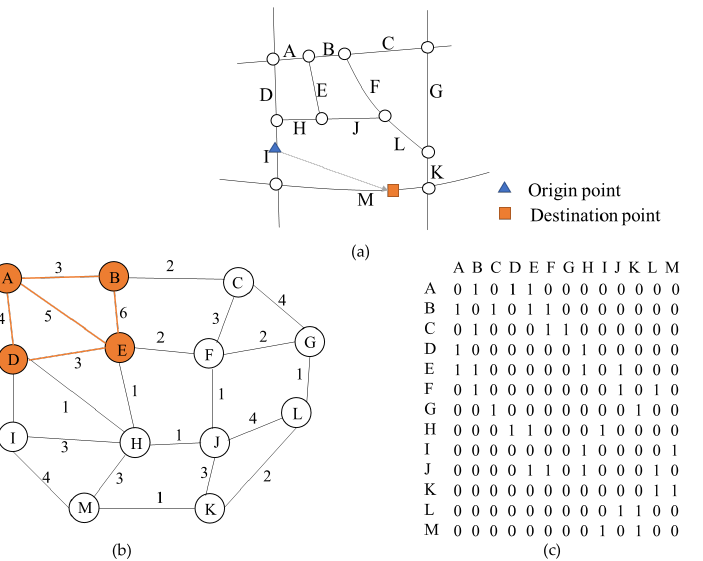
Figure 3. Construction of a weighted spatially embedded network: ( a ) road network and an OD pair; ( b ) the weighted spatially embedded network; and ( c ) spatial adjacency